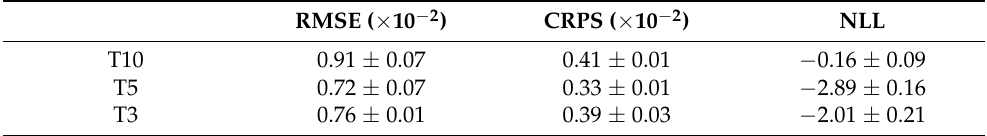
Table 5. Probabilistic prediction performance of NGBoost on dataset 1.